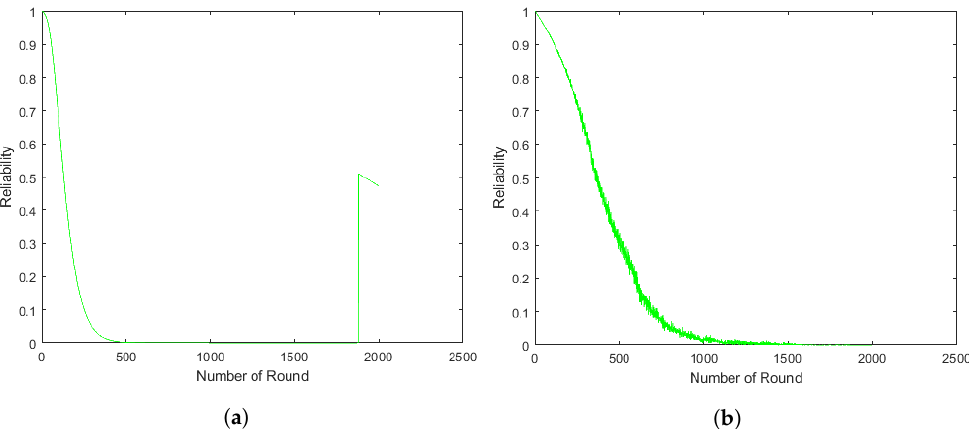
Figure 24. Multi-chain multi-hop mobile CHs energy reliability-based proposed RBD: yellow ( a ) D-Chain, ( b )